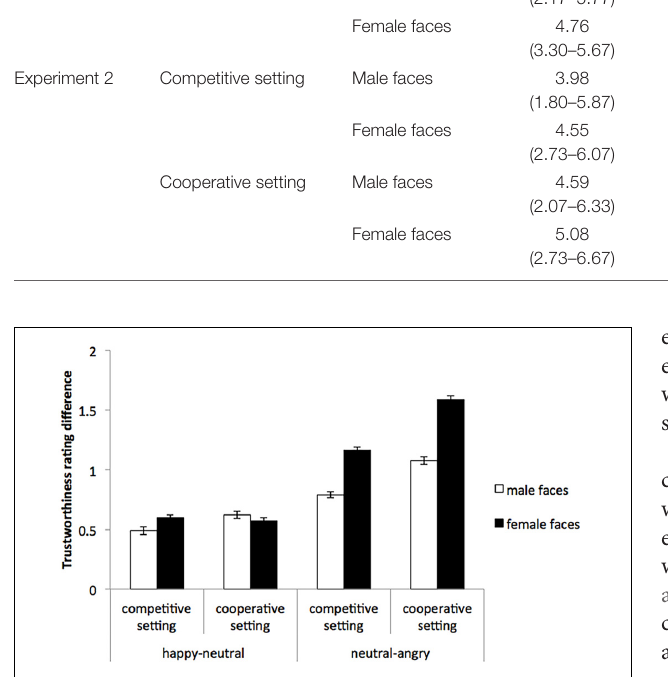
FIGURE 1 | The mean differences between trustworthiness ratings of the neutral and emotional faces in different genders in Experiment